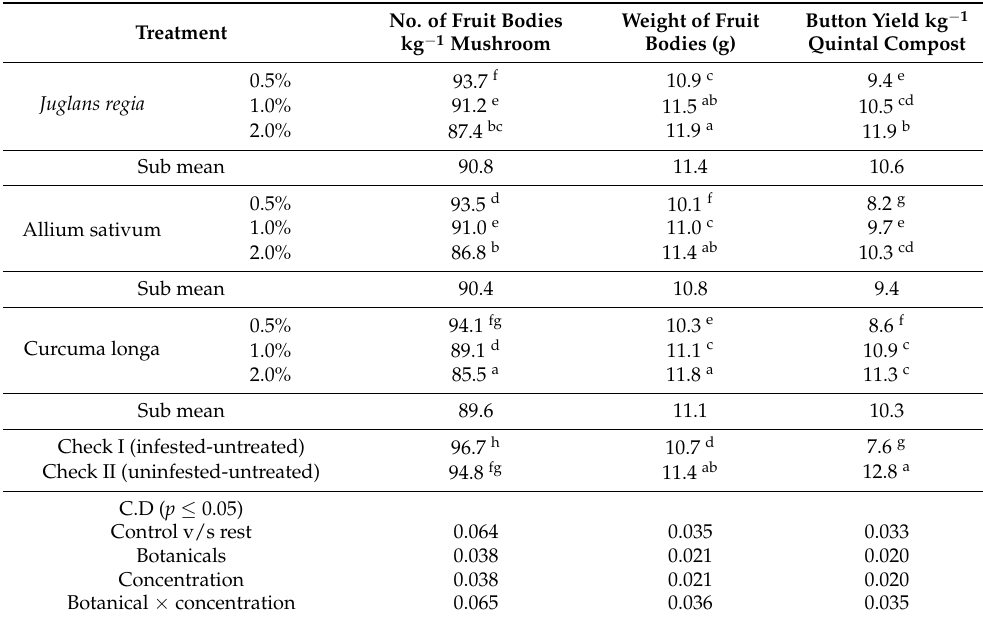
Table 5. Impact of botanical extracts on the number and weight of fruiting bodies and button yield under in vivo at concentrations between 0.5 to